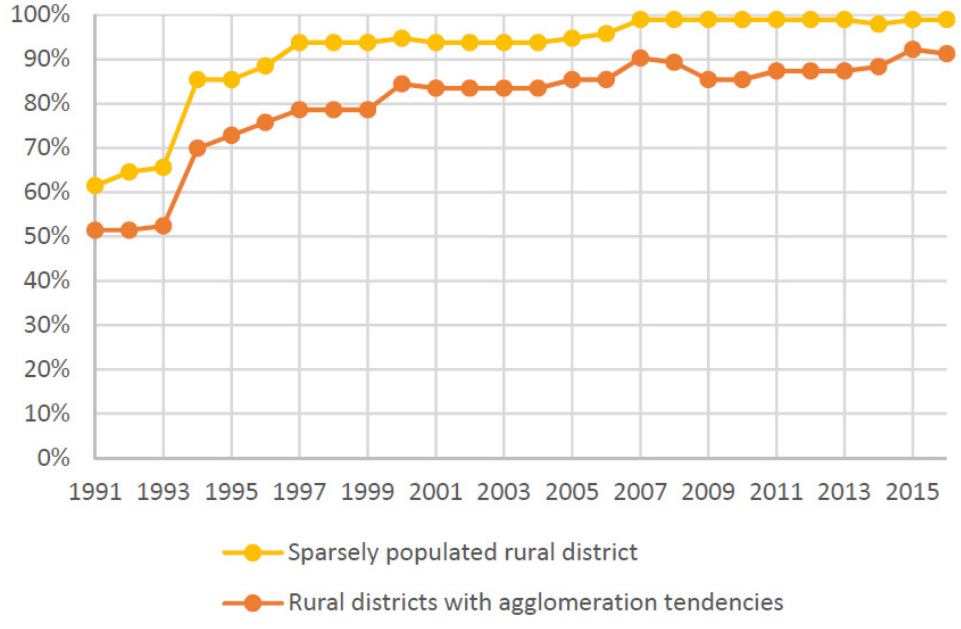
Figure 7. Deployment of programmes between 1991 and 2016 according to type of settlement structure in the districts (relative figures). Source: authors’ compilation (Department of Geography Giessen, Institute for Labour and the Economy Bremen).